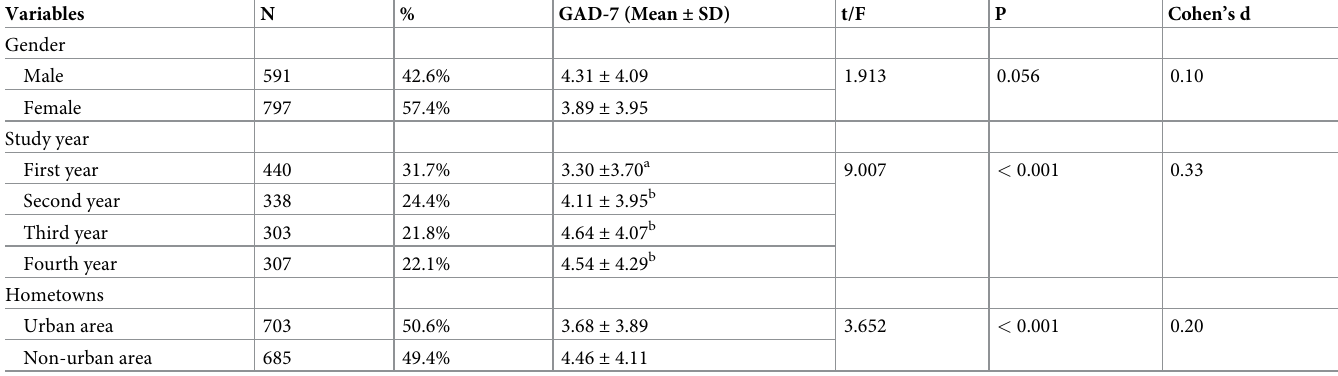
Table 1. Demographic characteristics and differences in anxiety (N = 1388).